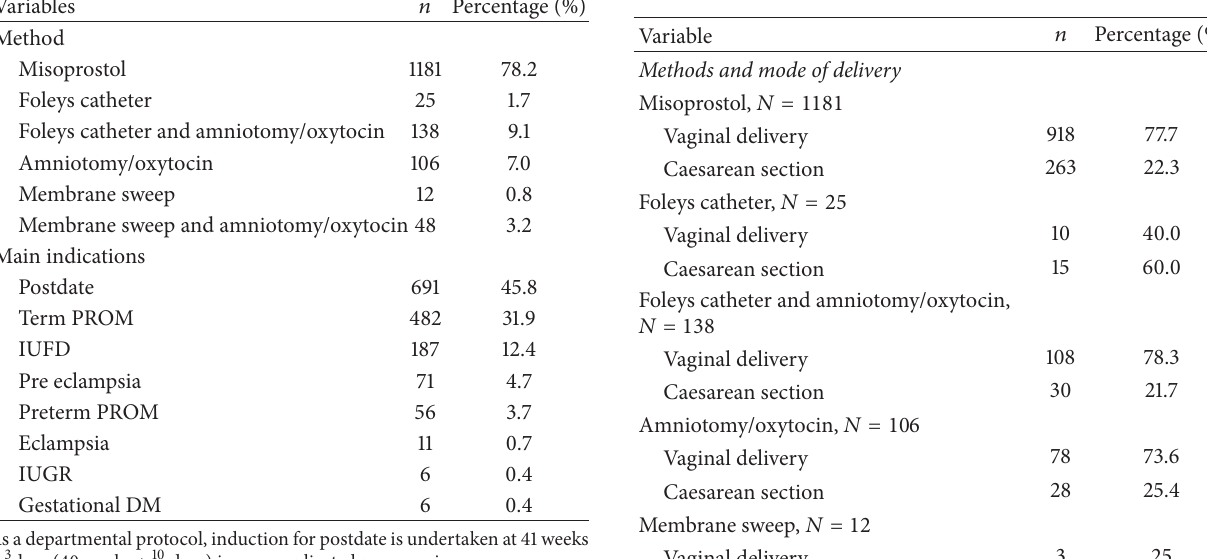
Table 2: Methods and indications for induction (𝑁 = 1510) . Table 3: Outcome of induction/mode of delivery of induced